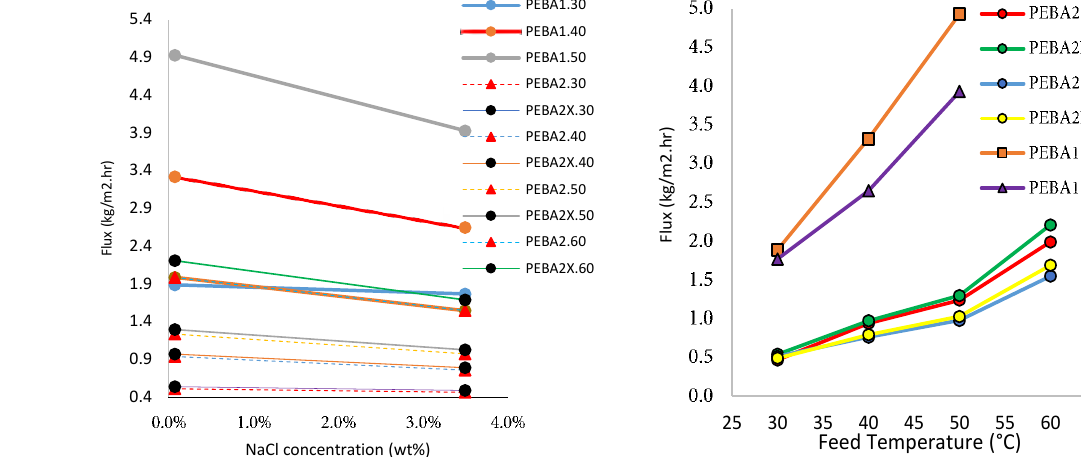
Fig. 6. Effect of feed concentration on water flux (vacuum 0.04 bar). Fig. 7. Effect of feed temperature on water flux (vacuum 0.04